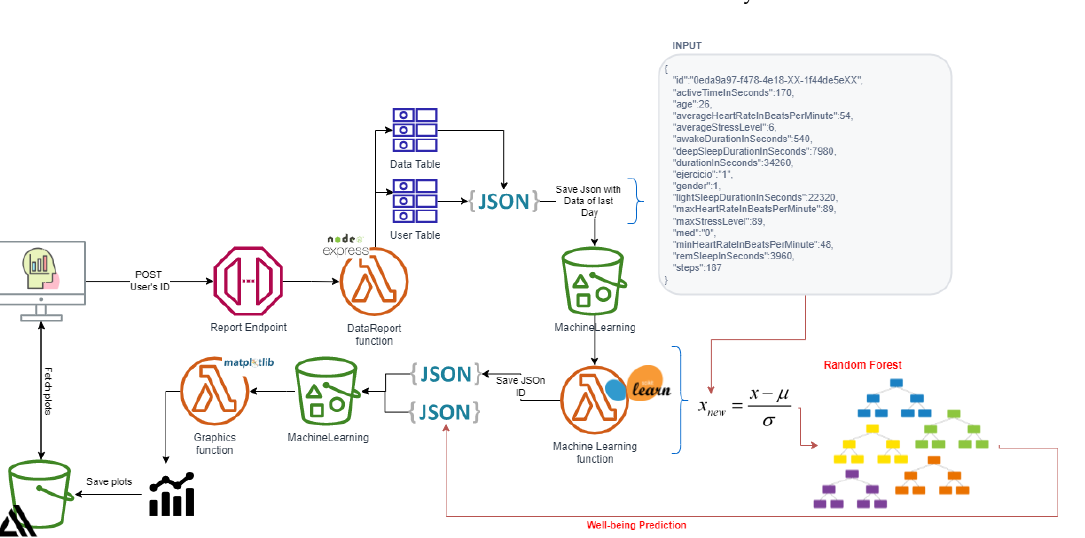
Figure 13. Classification